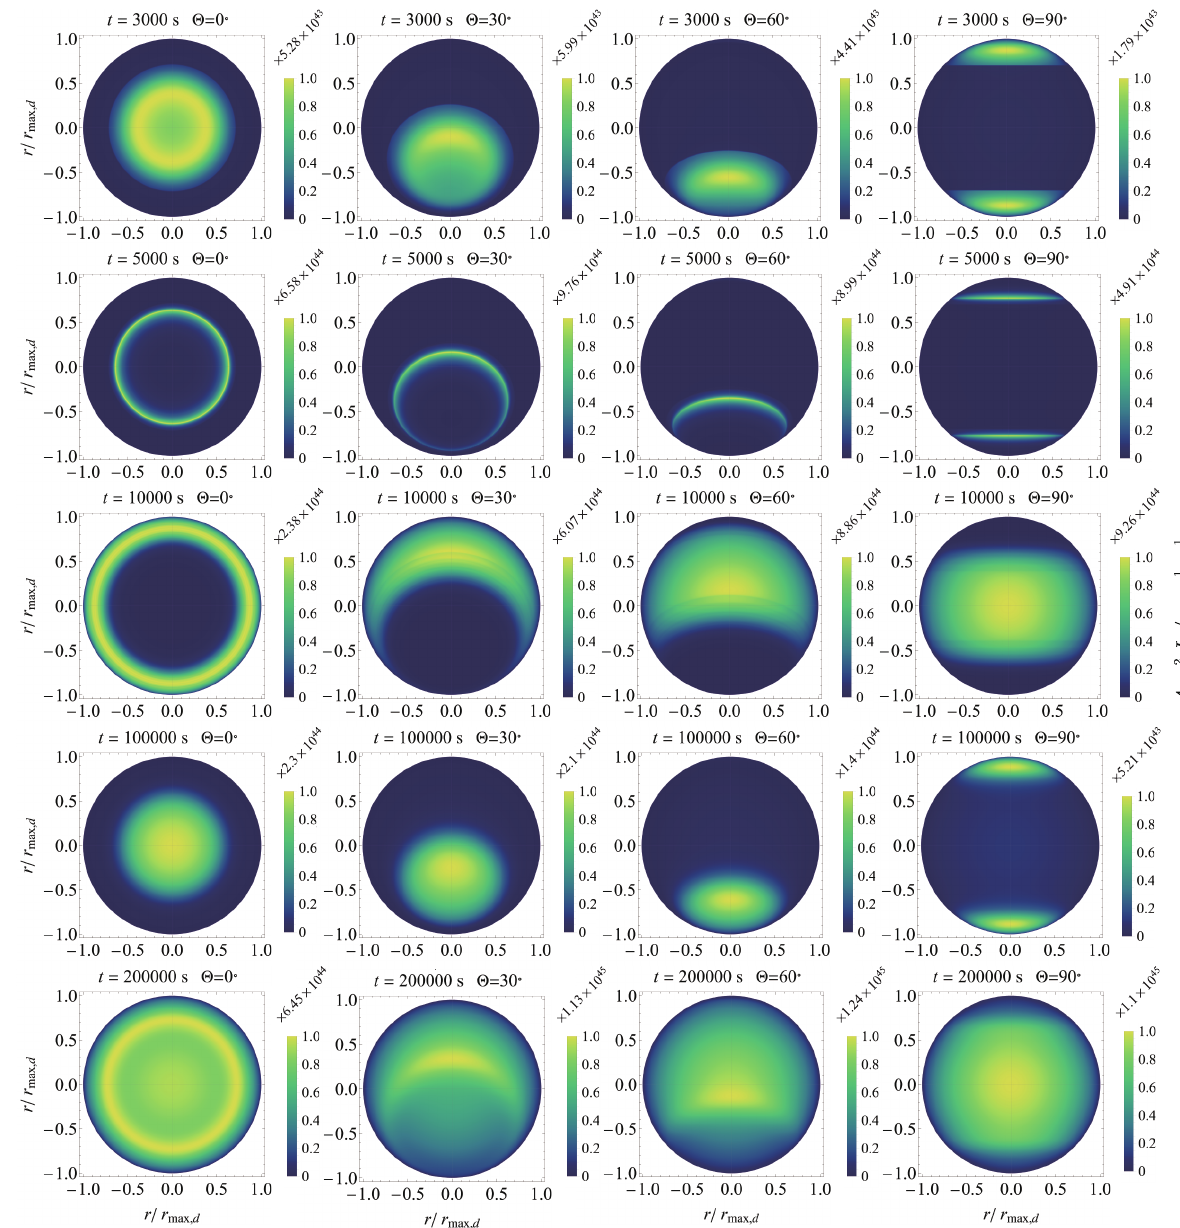
Figure 4. The intensity distribution on the emission surface for different times (rows) and different viewing angles (columns), for the Model A parameter